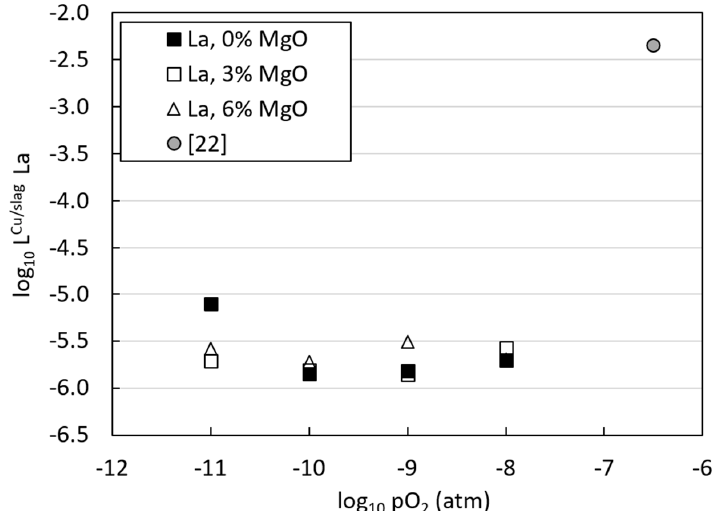
Figure 6. The distribution coefficient of lanthanum between copper alloy and molten slag. A result for neodymium (which behaves very similarly as lanthanum) from an earlier study [22] has been plotted for comparison.